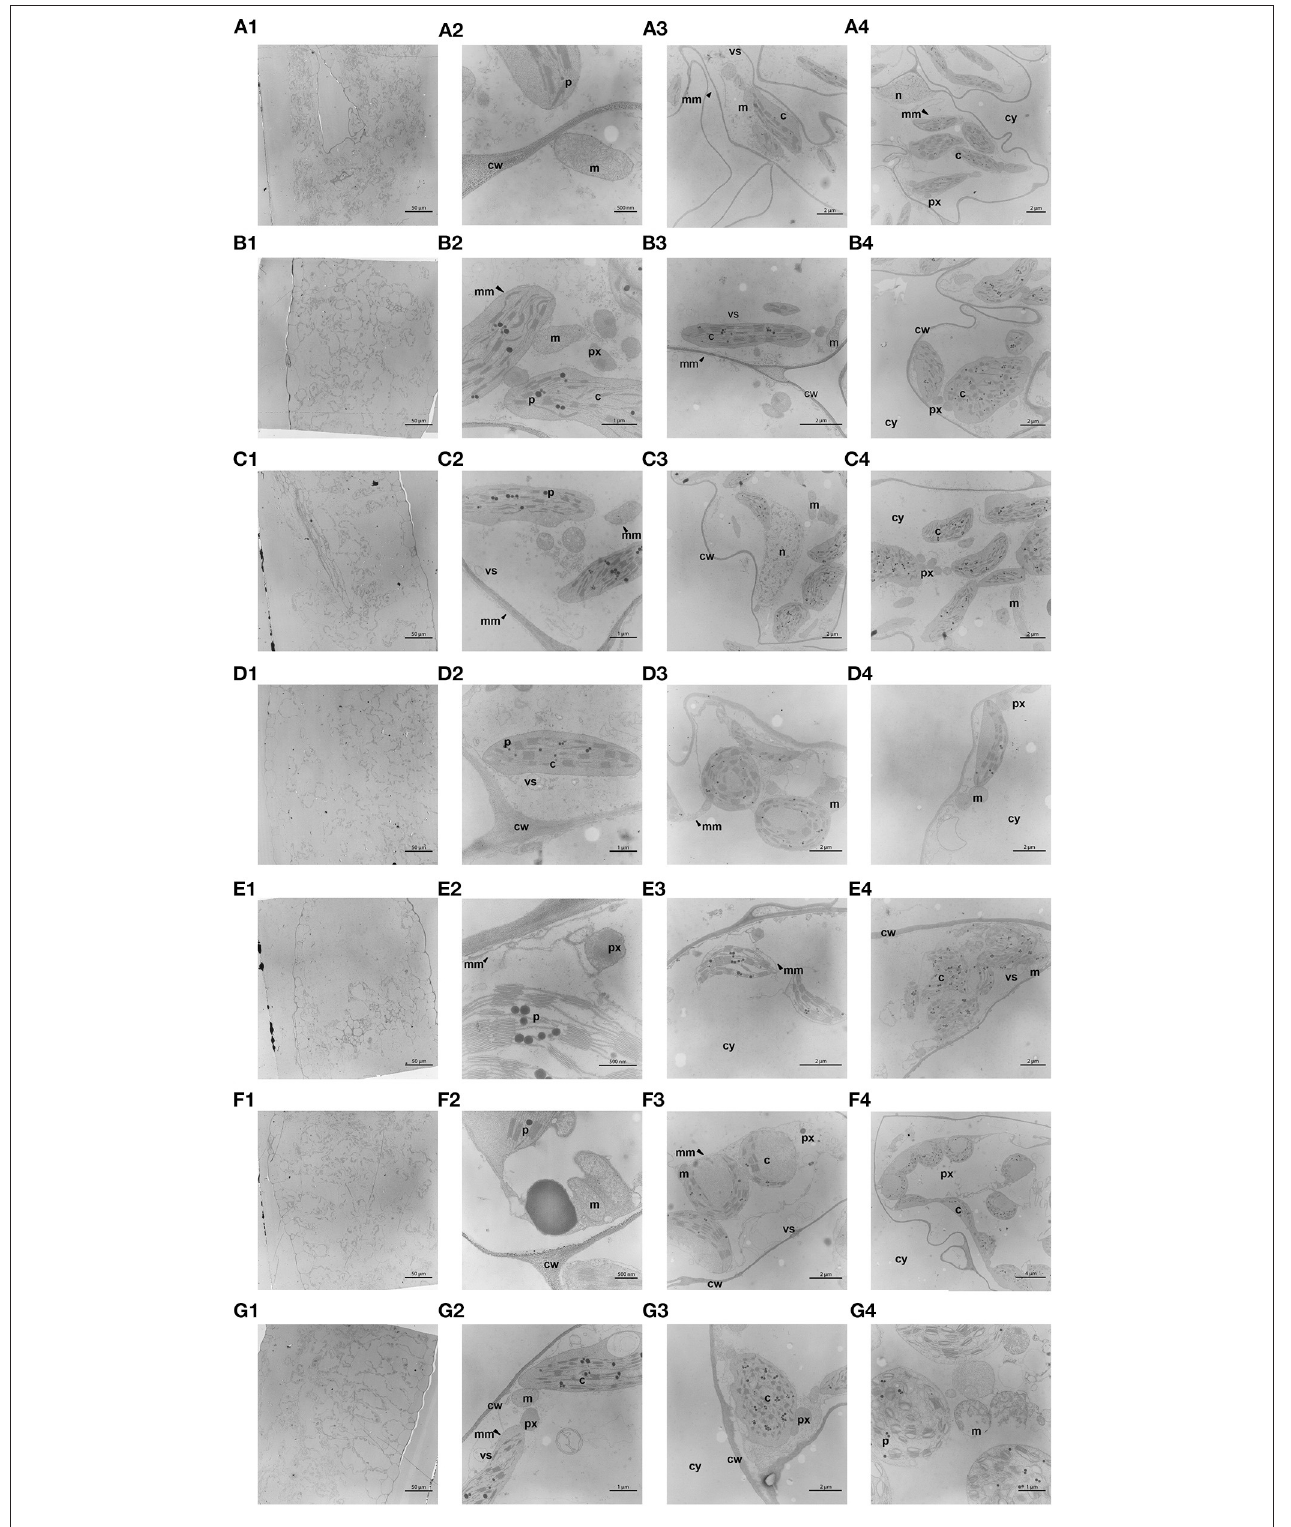
FIGURE 5 | Transmission electron microscopy (TEM) of the ultrastructure of the fresh-cut lettuce leaf tissue. For each process variant, four micrographs are shown: from left to right—overview of the ultrathin section, three times a detailed micrograph of the same section depicting all detected cell organelles. The process variants shown are: (A) unwashed (extraction point 0), (B) tap water washed (variant I), (C) PTW washed—variant II, (D) PTW washed—variant III, (E) PTW washed—variant IV, (F) PTW washed—variant V, (G) ClO 2 washed—variant VI. The organelles are: nucleus (n); cytoplasm (cy); cell wall (cw); chloroplast (c); mitochondrion (m); vesicle (vs); plastogloboli (p); peroxisome (px); membrane (mm; plasmalemma or tonoplast).